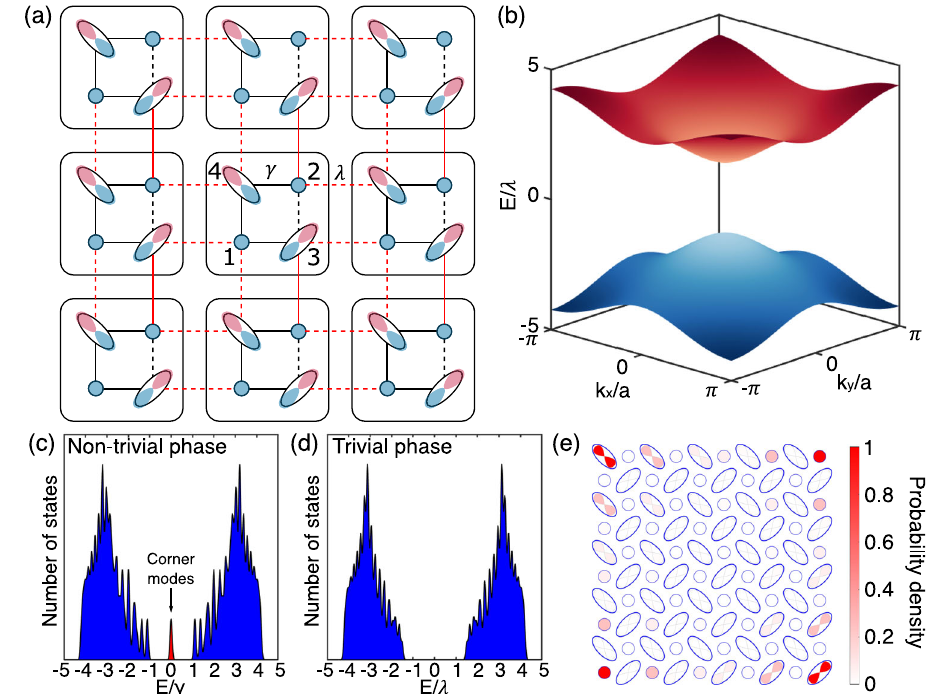
Fig. 2 | Quadrupole topological insulator using orbital-induced synthetic fl ux. a Schematicofthequadrupoletopologicalinsulatorwithorbital-inducedsynthetic fl ux. For the tight-binding model, E denotes the eigenvalues, and γ and λ are the nearest-neighbor coupling terms within (black) and across (red) unit cells, respectively. Dashed lines represent coupling terms with negative signs due to the overlap with the "negative part'' of the p orbital. Numbers indicate the basis of the